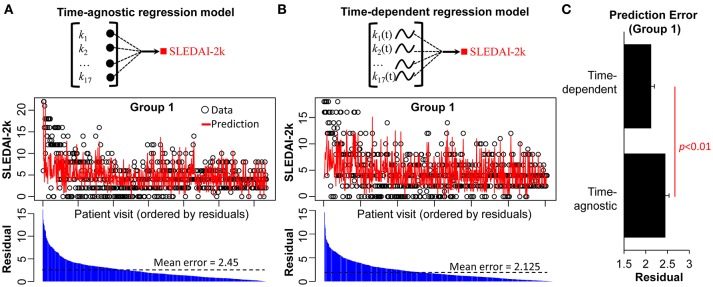
Predicted vs. actual SLEDAI-2K measures based on time-agnostic and time-dependent regression models. LOPO cross validation using (A) a time-agnostic regression model and (B) a time-dependent regression model. For each model, the predicted SLEDAI-2K of each patient visit is compared with the actual SLEDAI-2K. (C) Comparison between the prediction errors of time-agnostic vs. time-dependent regression model as applied to Group 1.